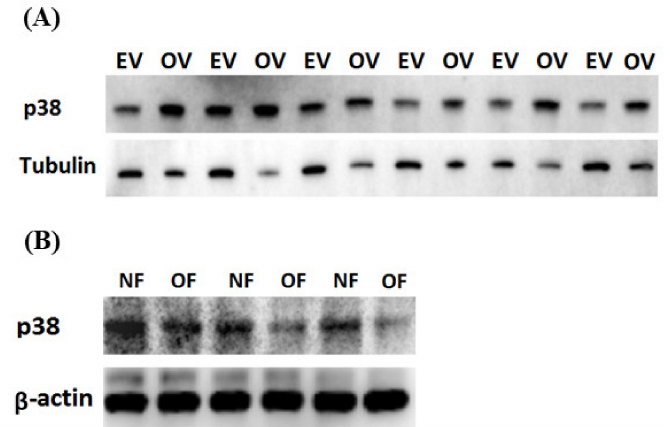
Figure 8. Total p38 protein level was associated with IGFBP5 expression in goose liver cells. Note: ( A ) Immunoblotting images showing that total p38 protein level was induced in goose primary hepatocytes transfected with IGFBP5 overexpression vector (OV) vs. empty vector (EV). ( B ) Im- munoblotting images showing that total p38 protein level was inhibited in the liver of the overfed (OF) geese vs. normally fed (NF)